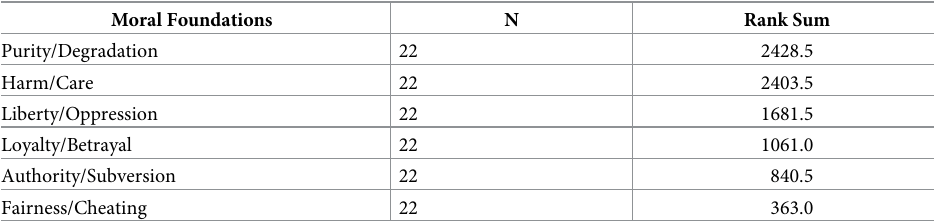
Table 3. Output for the Kruskal-Wallis test.